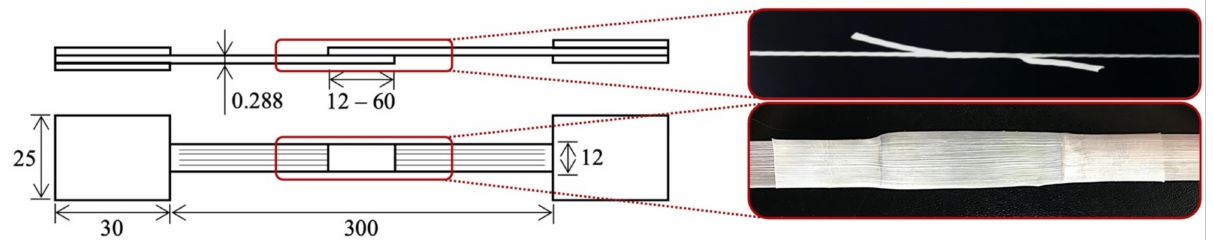
Figure 3. Single-lap co-cured sample